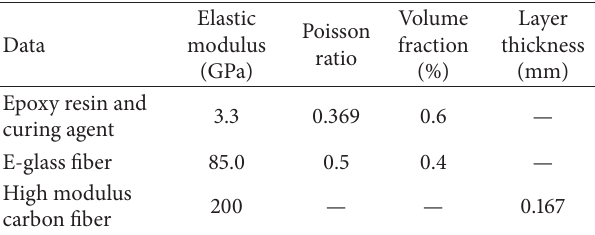
Table 1: Data of the raw